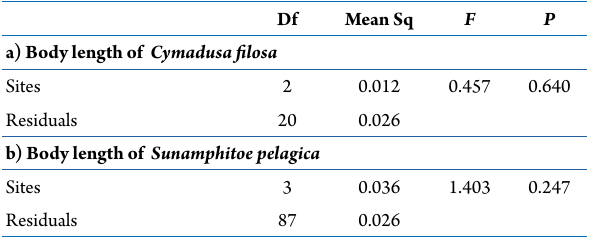
Table 6. ANOVA results for comparisons of the following parameters between sites: ( a ) male body length of Cymadusa filosa ; ( b ) male body length of Sunamphitoe pelagica